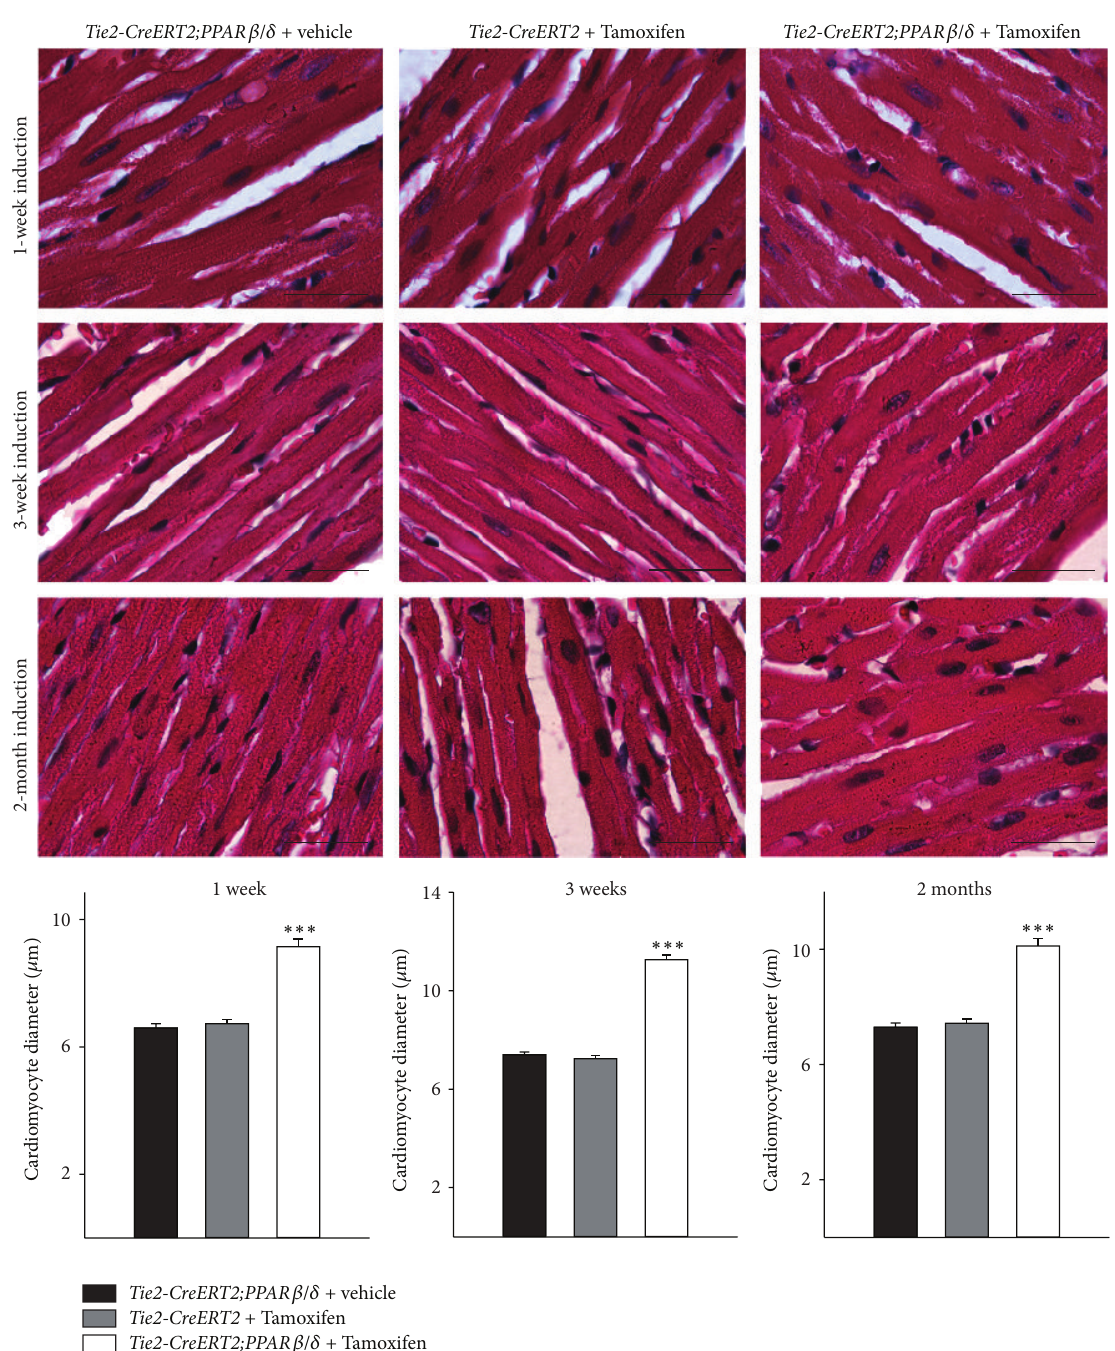
Figure 3: Enhanced cardiomyocyte diameter upon vascular-specific PPAR 𝛽 / 𝛿 overexpression. High power photomicrographs of HE-stained sections showing individual cardiomyocytes and quantification of cardiomyocyte diameters. Scale bars indicate 50 𝜇 m. Data are means ± SEM. ∗∗∗ 𝑝 < 0.001